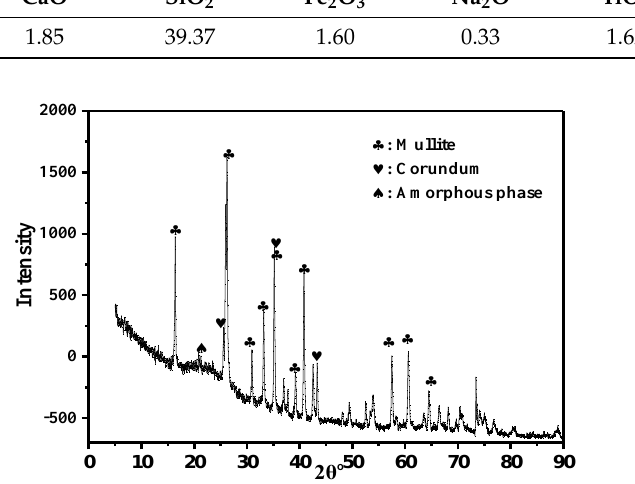
Table 1. Chemical composition of original HAFA (wt.%).